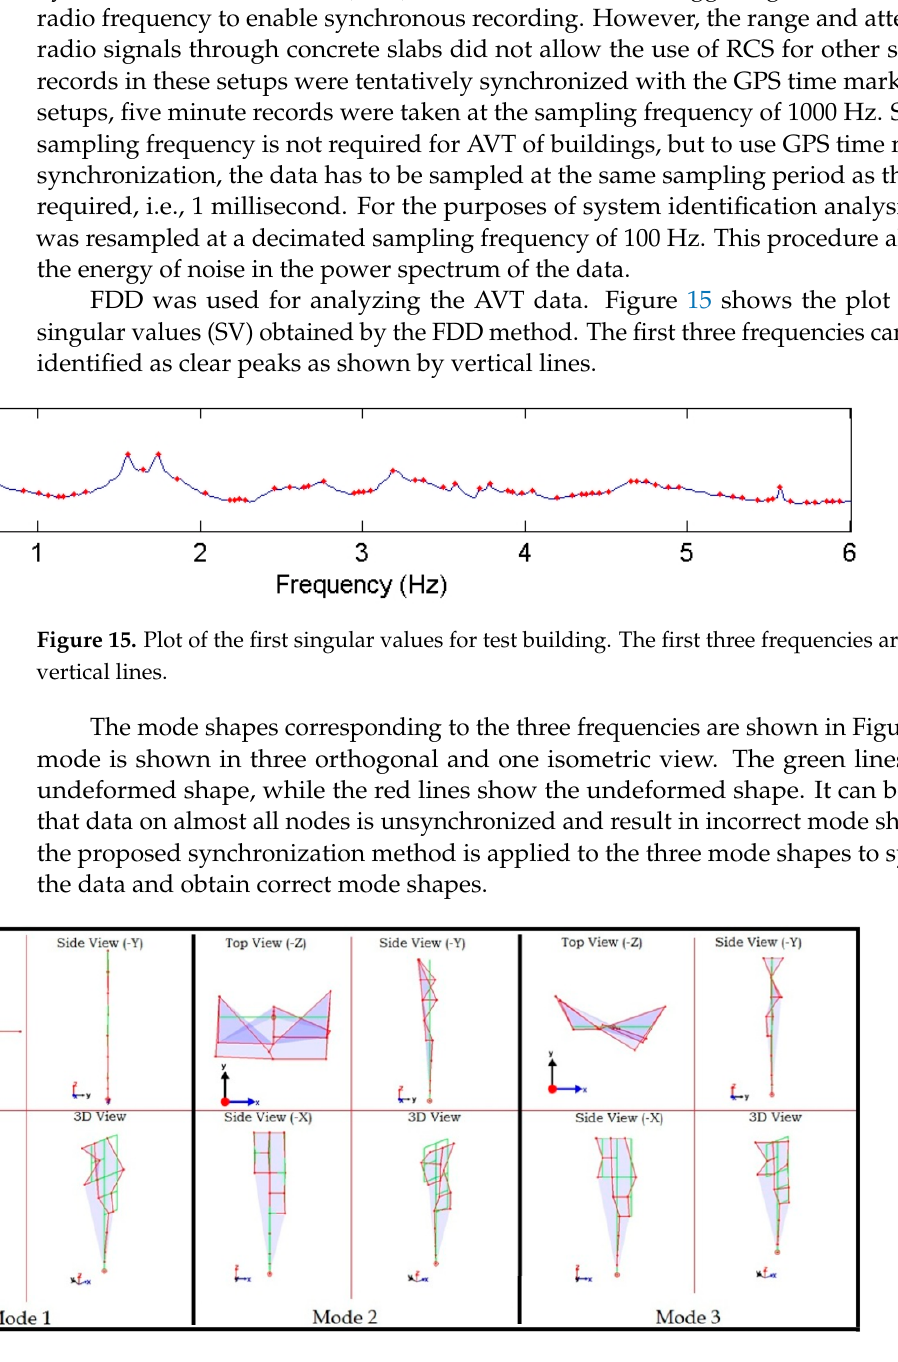
Figure 16. First three mode shapes: unsynchronized dataset.